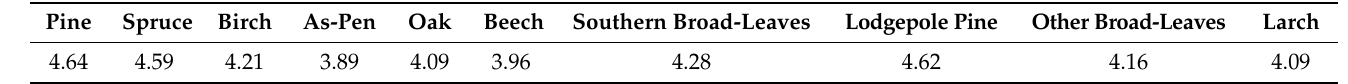
Table 1. Average form height of NFI plots years 2014–2018 in height interval 7–10 m (taking account of the difference between average height and dominant